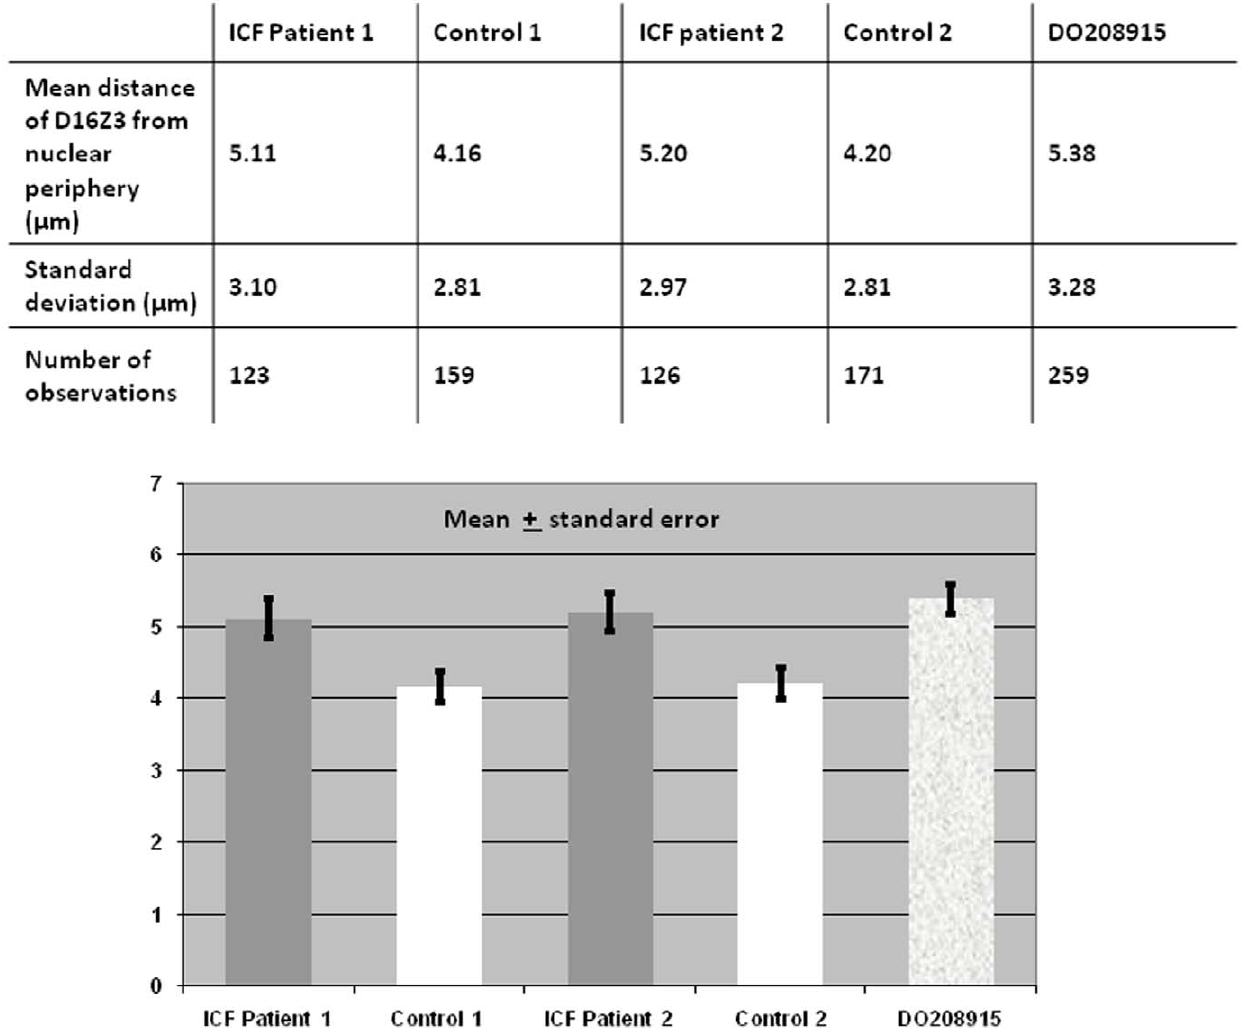
Figure 8. Chromosome 16 juxtacentromeric heterochromatin positioning in relation to the extreme nuclear periphery: distance measurements in ICF cells and controls. The average distance between the centroid of the chromosome 16 juxtacentromeric heterochromatic signal and the extreme nuclear periphery, as defined by the edge of the DAPI nuclear staining, was calculated in unsynchronised B-lymphoblastoid cells from ICF Patients 1 and 2, Controls 1 and 2 and DO208915. In contrast to previous observations, when performing a Kolmogorov-Smirnov test, there is no significant difference in the distance of D16Z3 to the nuclear periphery between ICF and normal cell lines (D=0.0558, P=0.678).